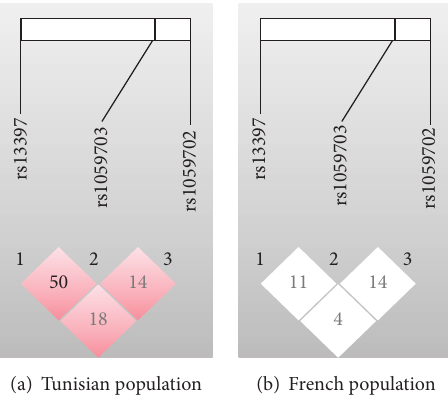
(b) French population Figure 1: Linkage disequilibrium (LD) between TMEM187-IRAK1 SNPs. Correlations ( 𝑟 2 values) among all 3 single nucleotide polymorphisms (SNPs) located in the TMEM187-IRAK1 locus are indicated in the diamonds for the Tunisian (a) and French (b) populations. Haploview 4.2 software was used for LD analyses. Table 5: TMEM187-IRAK1 genotypes for samples of RA and healthy controls in Tunisian and French female populations. Gene/SNPs